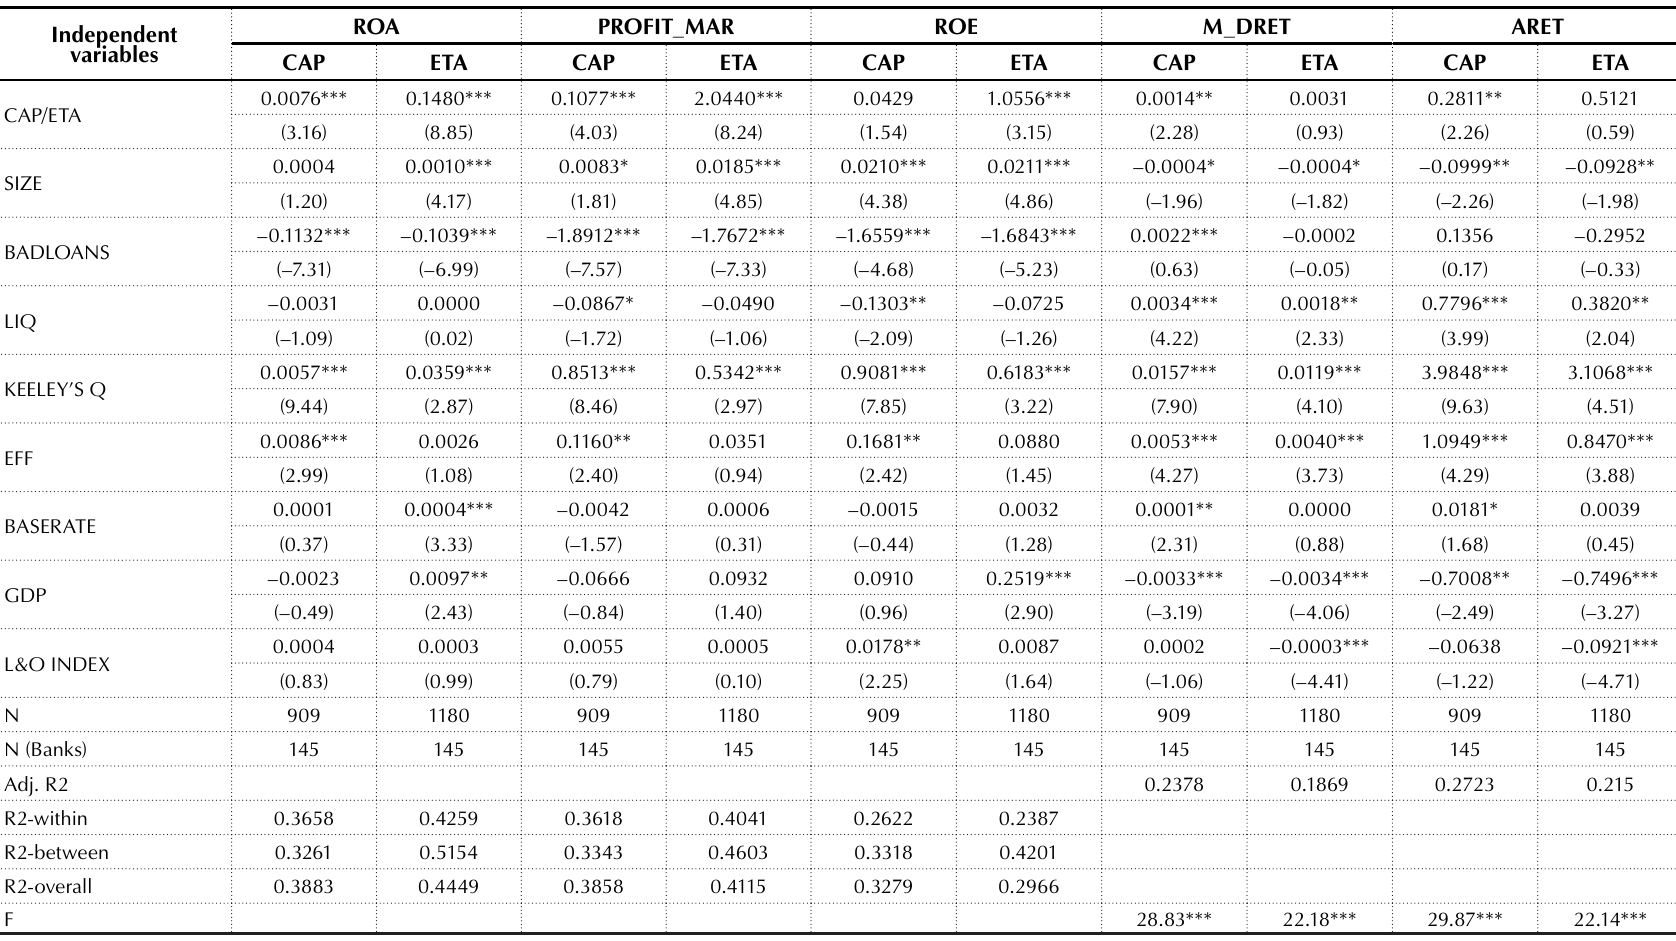
Table 7b. Regression results for accounting and market-based profitability measures for the European bank market from 1992 to